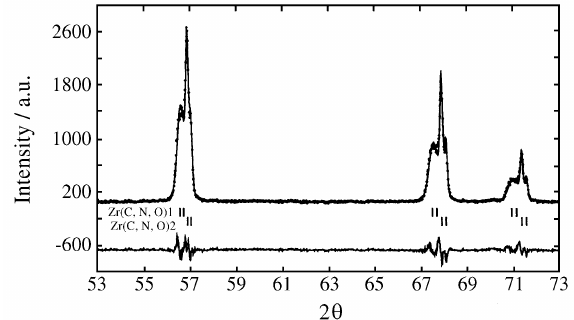
Figure 4. Diffractogram showing the unfolding of the Zr(C,N,O)